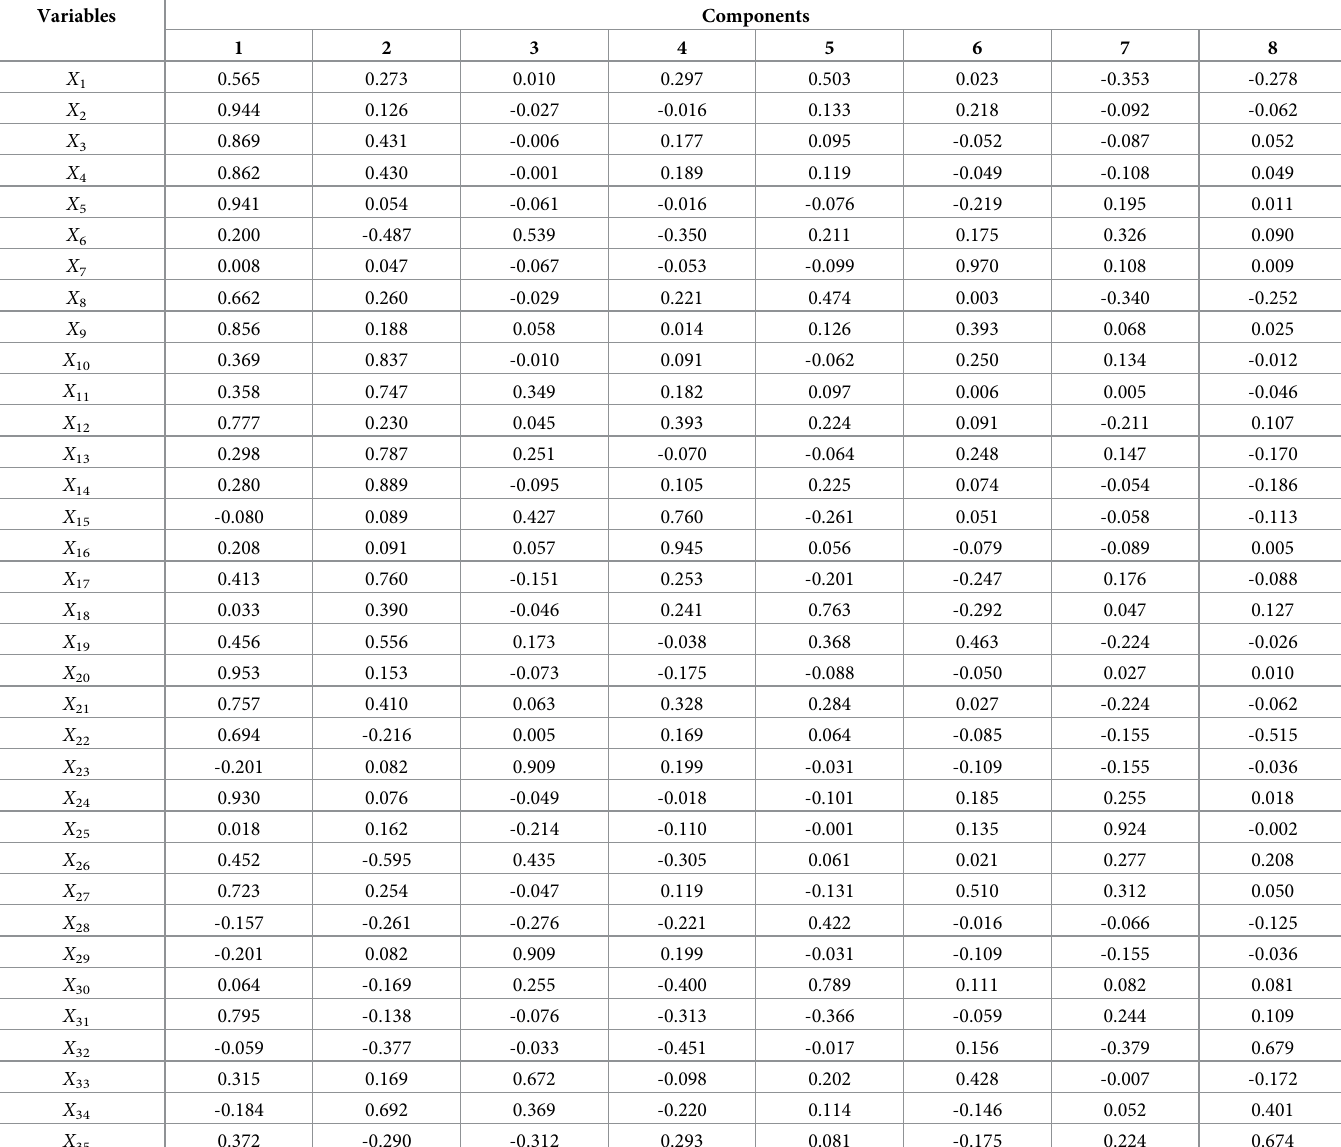
Table 3. Component rotating load